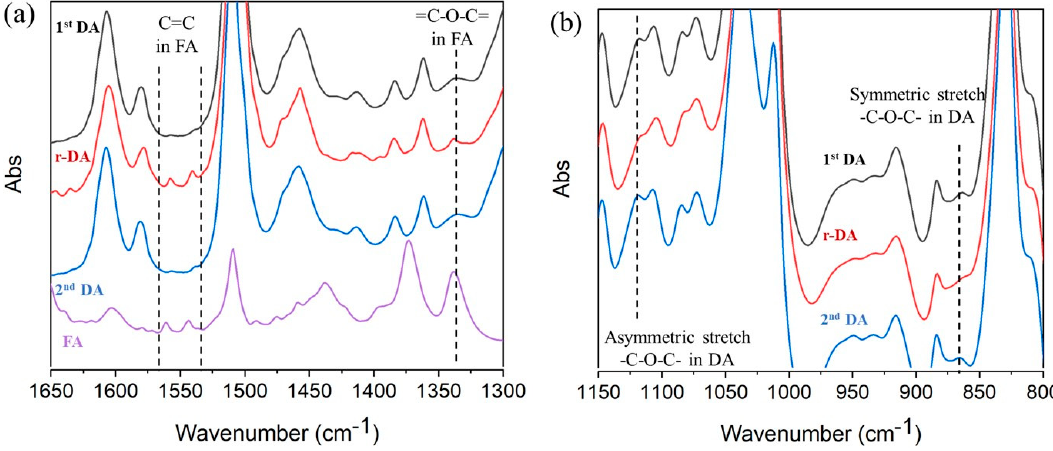
Figure 5. FT-IR spectra of GEN-0.1-D at various temperatures for wavenumbers ranging from 1650 to 1300 cm − 1 ( a ) and 1150 to 800 cm − 1 ( b ).